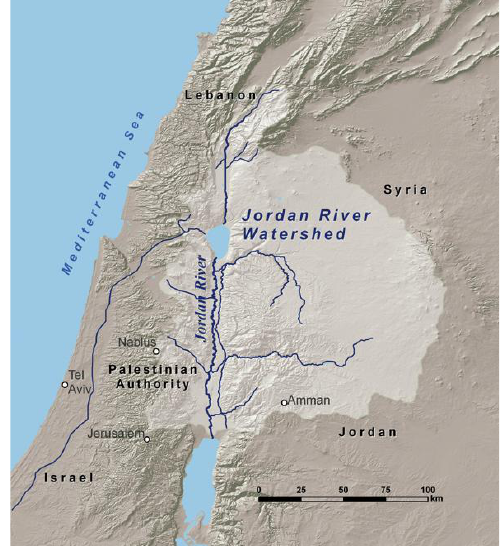
Figure 1. Jordan River Basin, including the upper catchment north of Lake Tiberias and the lower catchment south of the lake. The upper catchment is shared between Lebanon, Syria and Israel, the lower catchment is shared between Syria (Yarmuk), Jordan, Palestine and Israel. Map source: ESRI Data & Maps,